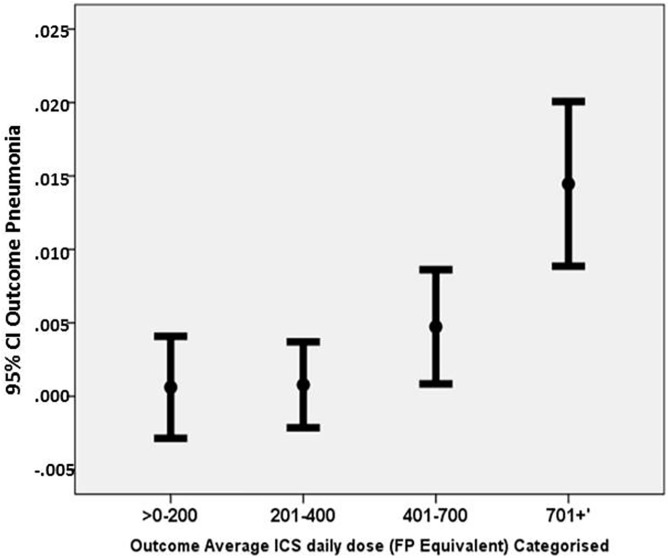
Probability (95% CI) of pneumonia in outcome period by average daily consumed ICS dose during outcome period.